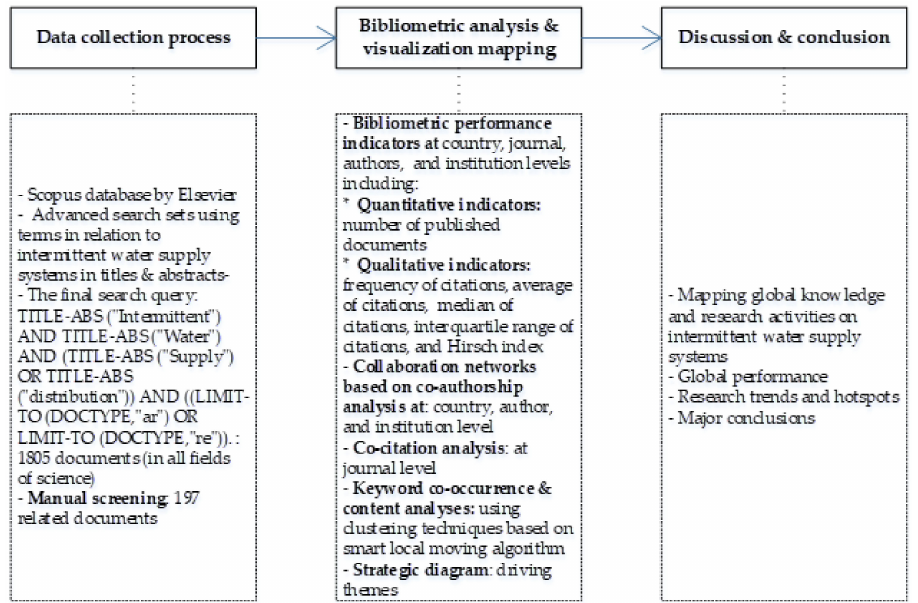
Figure 3. The roadmap outlines the entire analysis procedure including data collection, bibliometric analysis, and major